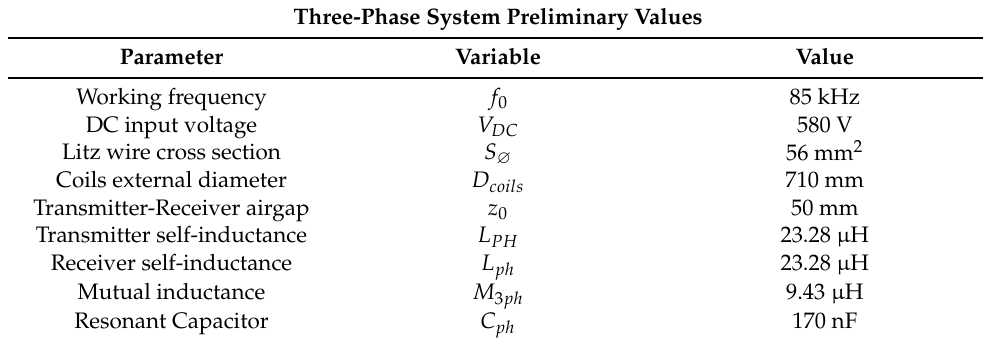
Table 1. Preliminary design parameters of the three-phase